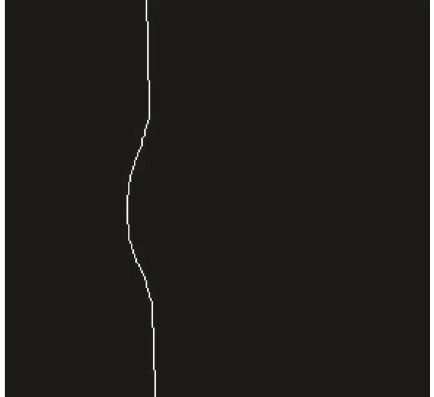
Figure 8: Multiple poststack height